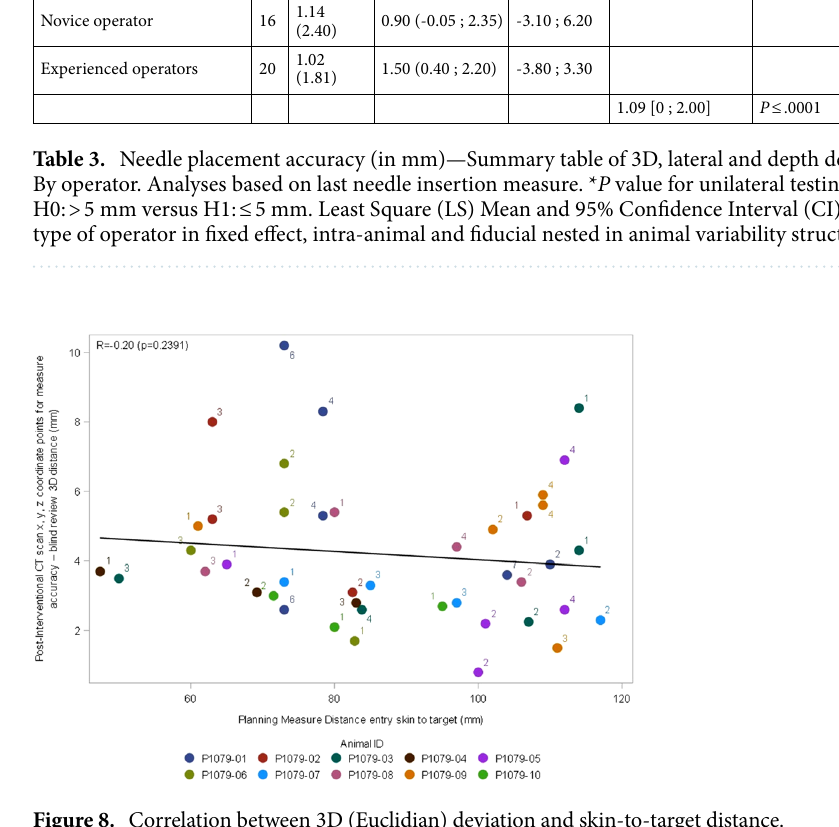
Figure 8. Correlation between 3D (Euclidian) deviation and skin-to-target